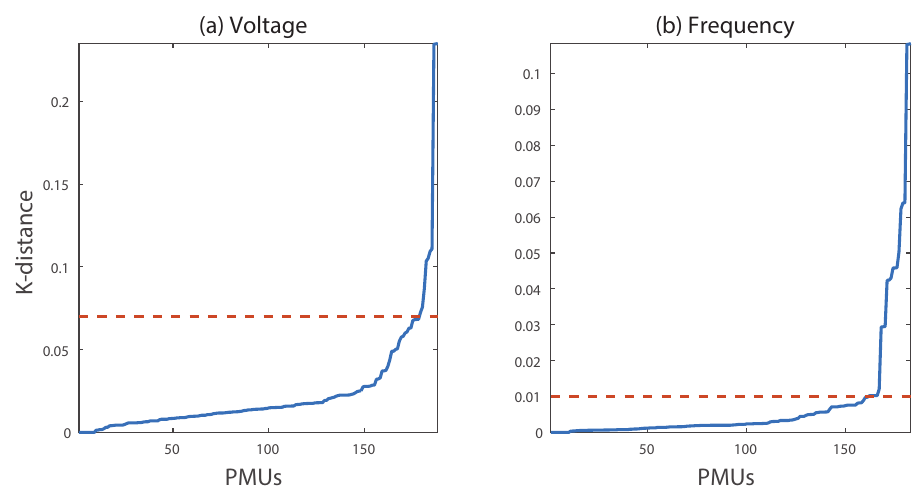
Figure 4. K-distance analysis. ( a ) Voltage dataset, ( b ) frequency dataset.